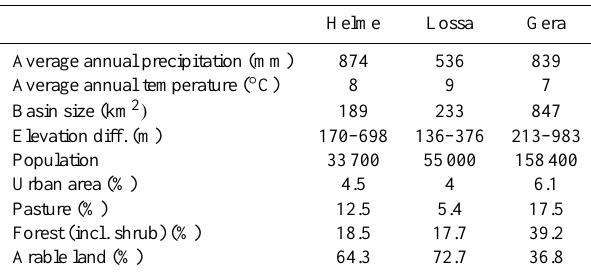
Fig. 1. Test catchments and the landscape types of Thuringia (Hiekel et al., 2004). Coordinate System: Gauss-Kr ¨ uger (GK 4, 31468). Table 1. Overview over the catchment characteristics of the test- catchments (changed after B¨ase et al.